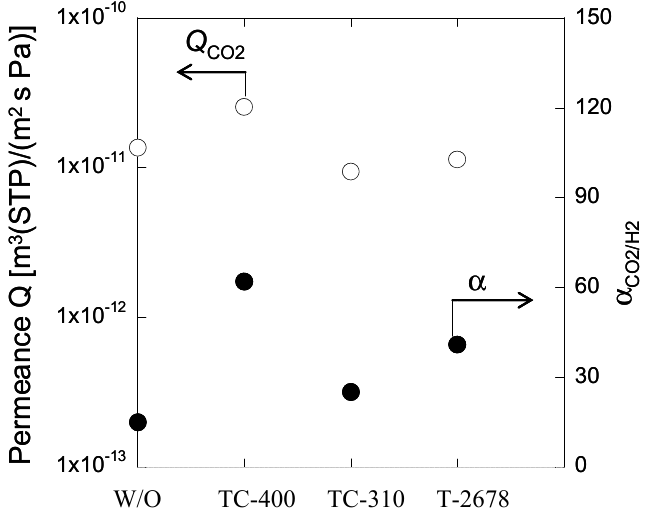
separation properties of PAMAM/cross-linked PVA 2 partial pressure and 80% relative humidity 2